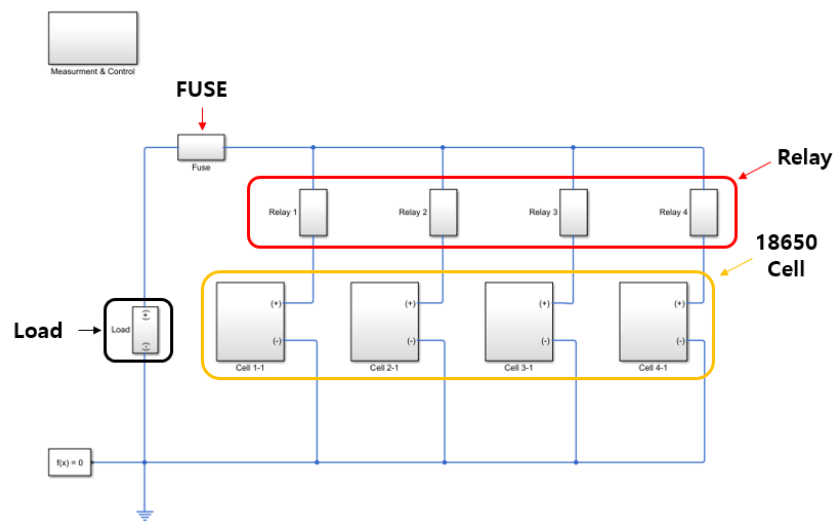
Figure 10. Software model of 1S4P battery pack.